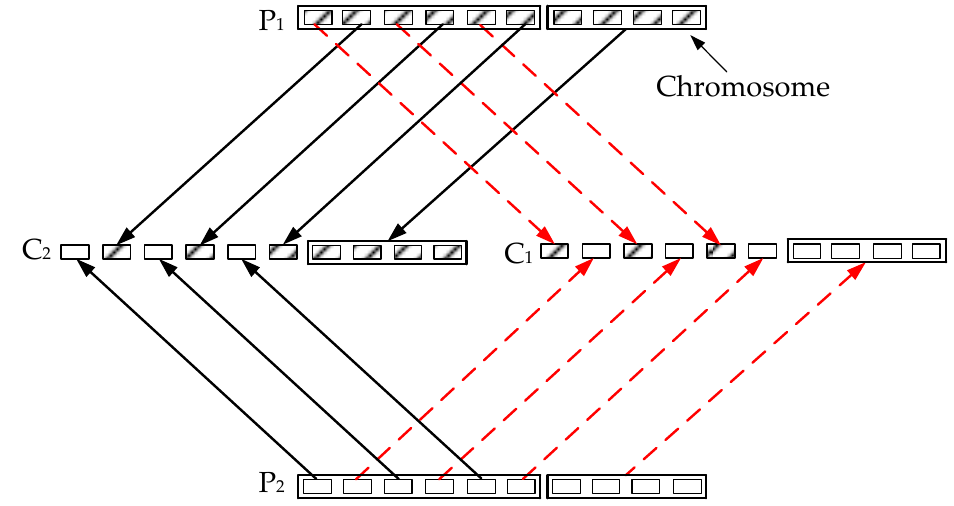
Figure 3. Modified crossover method.